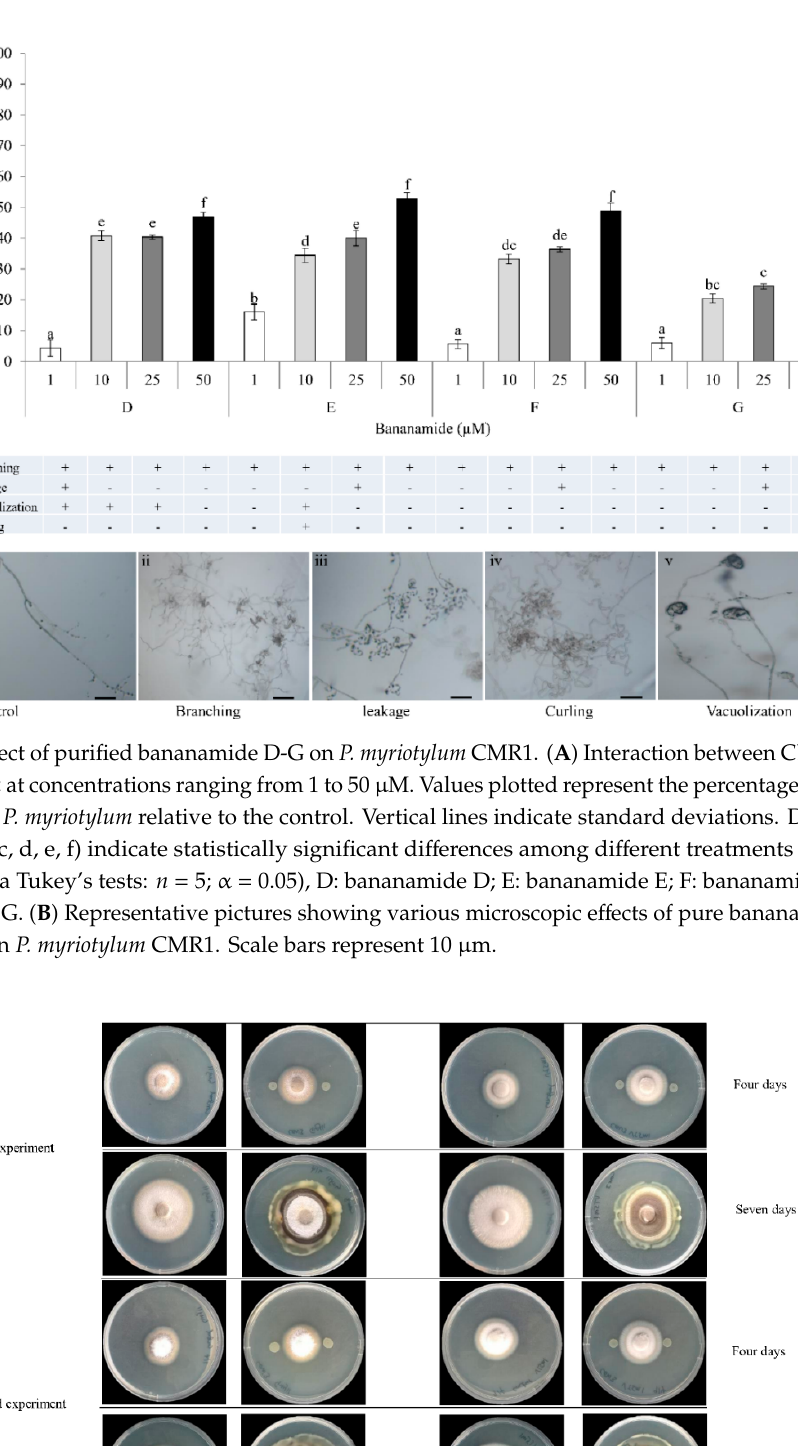
Molecules 2019 , 24 , x 10 of 28 Figure 7. In vitro antagonistic effect of COW3 on P. myriotylum . Co-culturing of bananamide D-G- producing strains COW3, with P. myriotylum CMR1. ( A ) Percentage inhibition of CMR1 by COW3. Representative pictures were taken after two and four days, respectively. The experiment was conducted with 6 replicates and was repeated in time. The two experiments are shown. Vertical lines indicate standard deviations. Different letters (a, b, c) indicate statistically significant differences among different treatments (Anova followed by a Tukey’s tests: n = 6; α = 0.05), D: bananamide D; E: bananamide E; F: bananamide F; G: bananamide G. ( B ) Representative pictures showing the inhibition of P. myriotylum CMR1 by COW3.